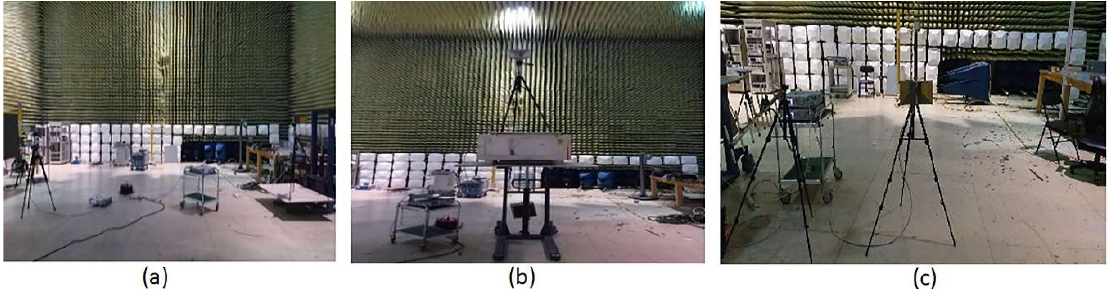
Figure 10. Settings of the boundary experiment. ( a ) left and right boundary; ( b ) upper boundary; ( c ) lower boundary.